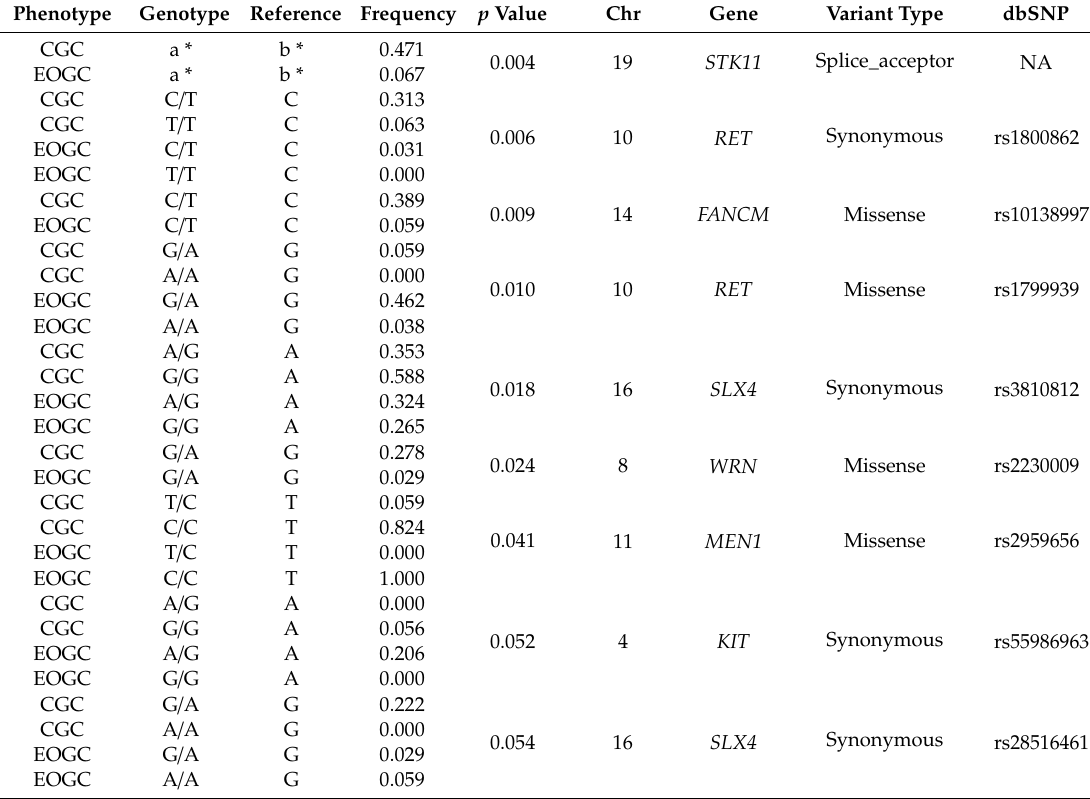
Table 1. Candidate genes employed for age-dependent classification of gastric carcinoma.